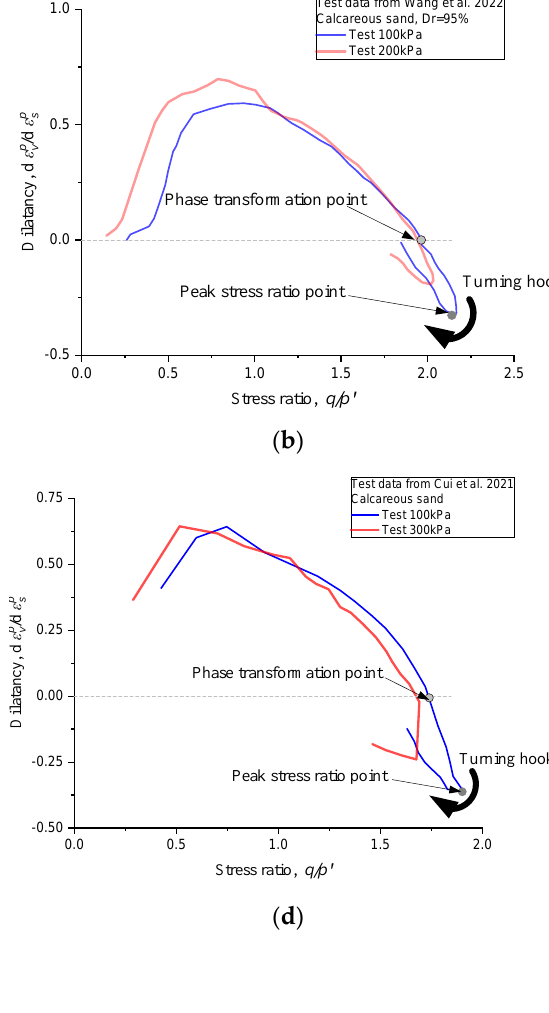
Figure 1. The turning hook of the stress − dilatancy curve corresponds to the main part of the loading process:( a ) stress ratio versus axial strain curve and volumetric strain versus axial strain curve; ( b ) stress-dilatancy curve. (Data from Wu et al., 2021 [1], calcareous sand, confining pressure = 100 kPa).